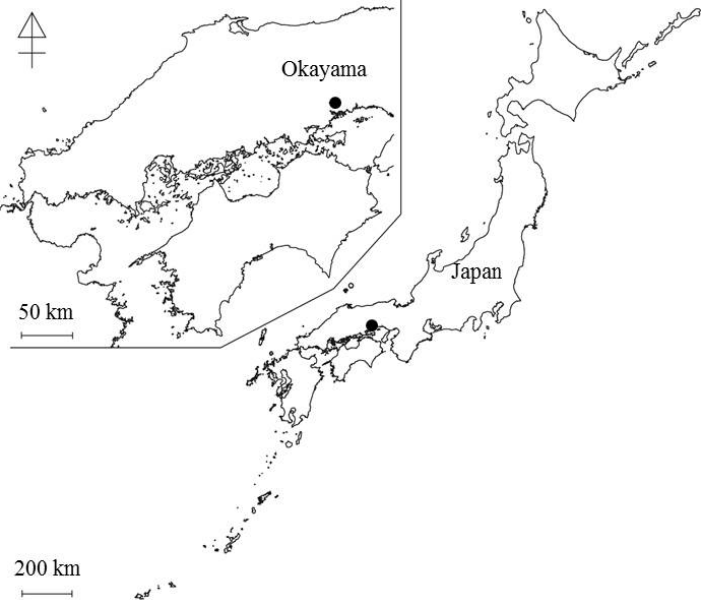
Figure 1. A location map of study area (indicated by black dots).